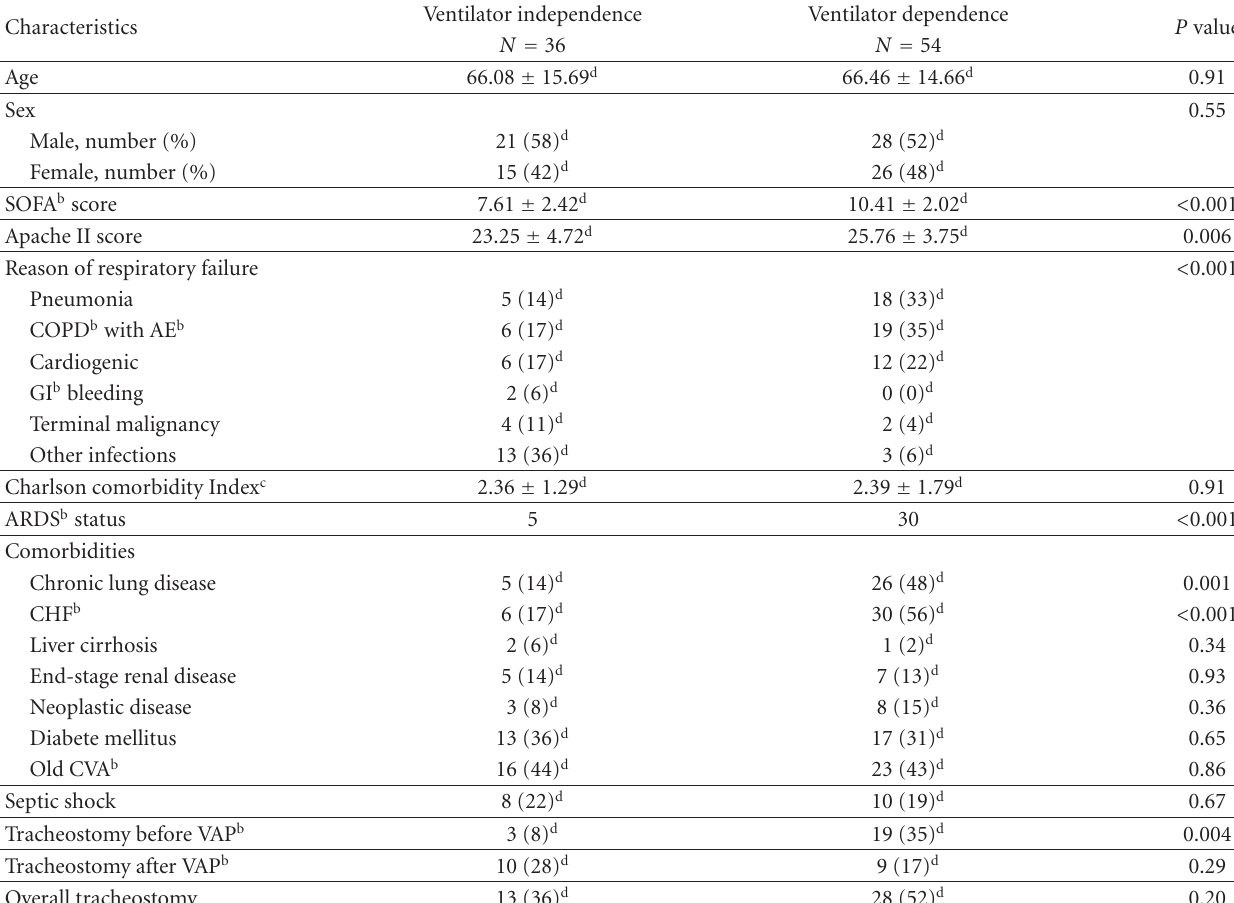
Table 2: Baseline VAP patients characteristics a